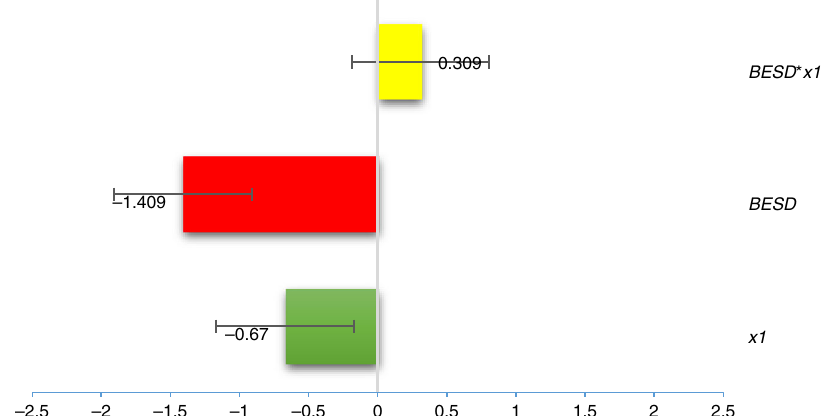
Fig. 2 The dilution effect on the building energy saving standard. The in fl uence coef fi cients of BESD, the building area per household and their interaction term (BESD* x 1 ) on the URBEC per square meter